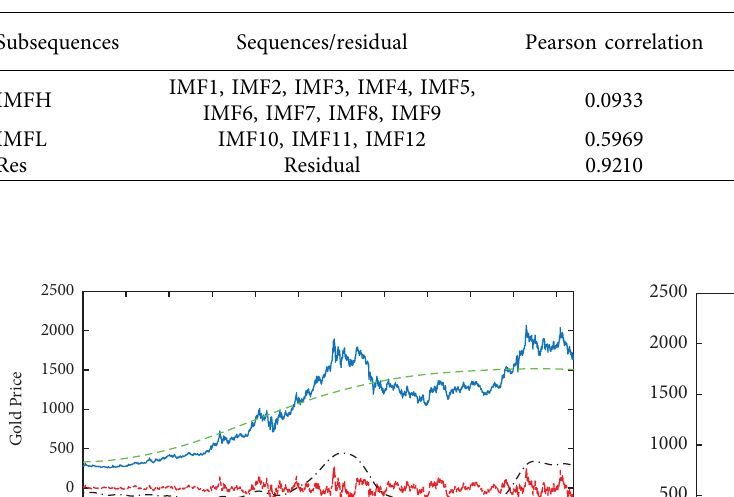
Table 4: Reconstructed results of the original gold price data.